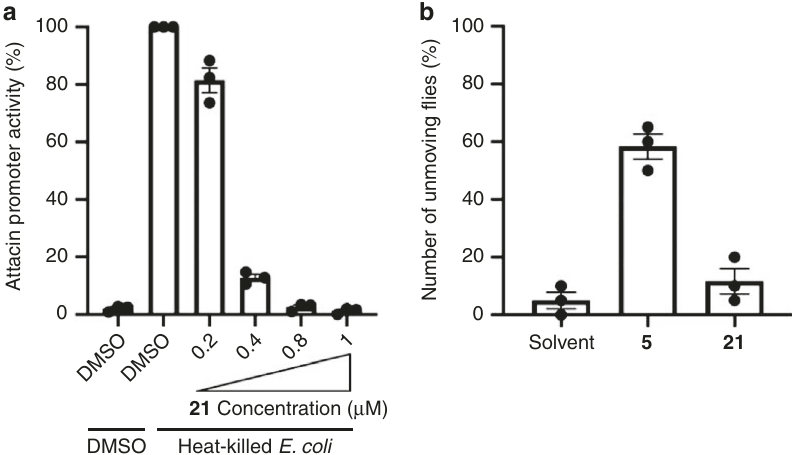
Fig. 6 Biological activity against Drosophila . a Inhibitory effect of compound 21 on the IMD pathway Drosophila l(2)mbn cells were stimulated with heat- killed E. coli and the activity of the Attacin promoter, a read-out of the activation of the IMD pathway, was monitored by a luciferase assay. Data are means ± SEM of triplicate wells from a single experiment and are representative of two independent experiments. b Toxic effect of compound 5 on Drosophila adult. Adult fl ies (c.a. 1 mg each) were injected with the indicated compounds (3.5 ng each), and the fl ies that did not show movement or only faint shaking of their legs were counted as unmoving fl ies. Data are the means ± SEM of triplicate samples from a single experiment and are representative of two independent experiments. Source data underlying Fig. 6a, b are provided in a Source Data fi